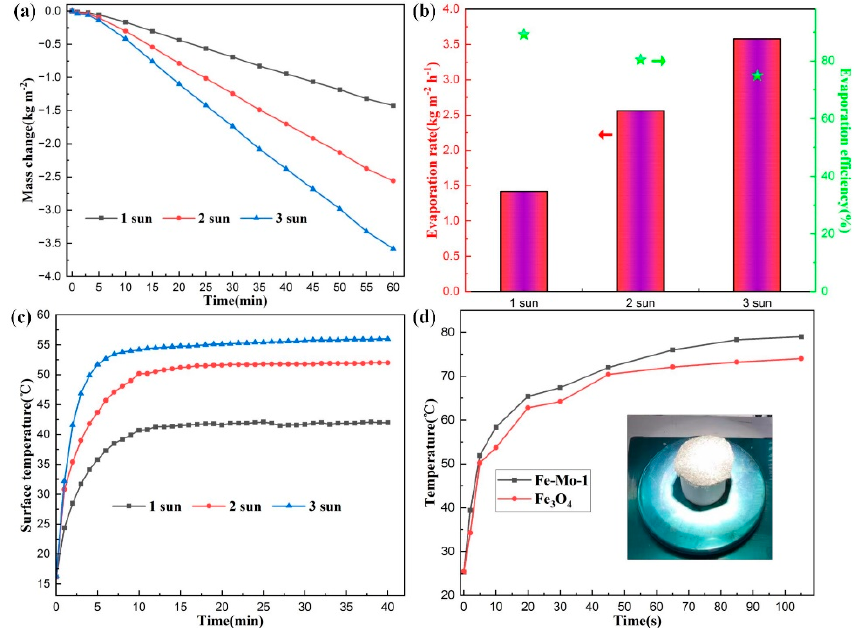
Figure 5. ( a ) The mass change of the Fe-Mo-1 sample with time under 1, 2, and 3 sun irradiation, respectively. ( b ) Evaporation rate and evaporation efficiency of Fe-Mo-1 under 1, 2, and 3 sun irradiation, respectively (The bar graph corresponds to the evaporation rate on the left axis and the pentagram corresponds to the evaporation efficiency on the right axis). ( c ) The surface temperature trend diagram of Fe-Mo-1 with time under 1, 2, and 3 sun irradiation. ( d ) Time dependent trend graph of surface temperature under 1 sun irradiation for Fe-Mo-1 (dried) and Fe 3 O 4 (dried); inset is the physical picture of the sample at the time of experiment.